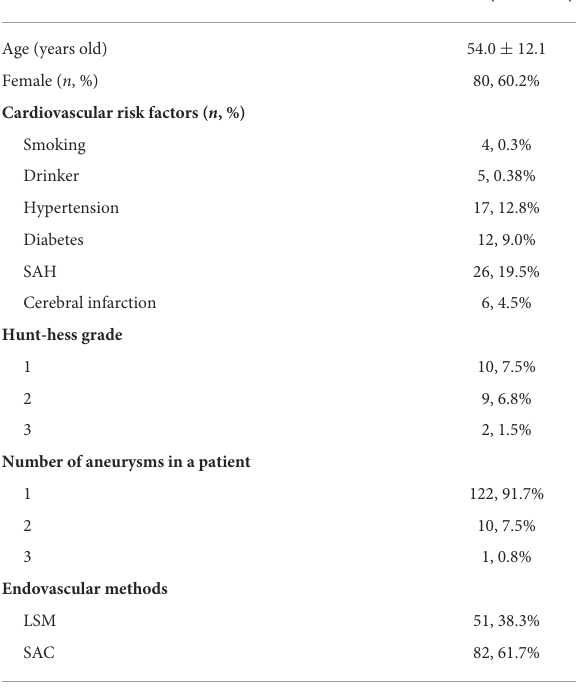
TABLE 1 Characteristic of 133